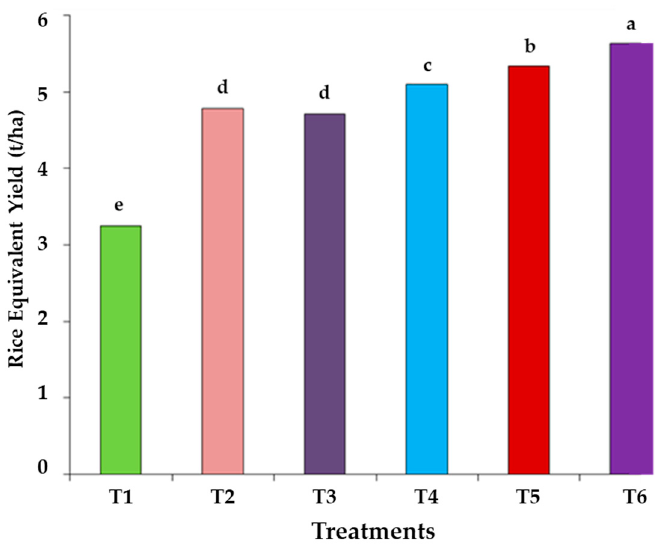
Figure 6. Effect of organic amendments on rice equivalent yield (REY). Note: T1, control without fertilization; T2, farmyard manure (FYM); T3, green manure (GM); T4, GM + biofertilizers (BF); T5, FYM + GM; T6, FYM + GM + BF. Letters represent significance of results among different treatments.